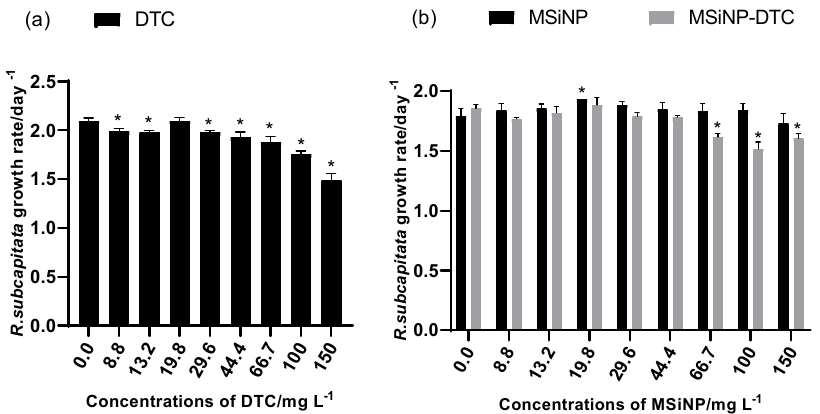
7 100 150 4 6 8 2 8 0 66 . 44 . 29 . 19 . 13 . 8 . 0 . Figure 7. Average R. subcapitata growth rate after 72 h of exposure to DTC ( a ), MSiNPs, and MSiNP-DTC ( b ). Error bars represent the standard deviation, and * corresponds to significant differences between the respective control and the treatments (Dunnett’s test: p < 0.05). DTC: 3-methyl-5-phenyl-pyrazoline-1-( S -benzyldithiocarbazate); MSiNP: mesoporous silica nanoparticles; MSiNP-DTC: DTC-loaded silica nanoparticle. The concentrations of MSiNP-DTC are based on MSiNPs. The amount of DTC in 150 mg L − 1 of MSiNPs is 7.18 mg L − 1 . Currently, there are only a limited amount of data on the effect concentrations ob- served for L. mi nor regarding SiNPs [16,61], and none are related to DTC or analogous compounds. The effects of DTC, MSiNPs, and MSiNP-DTC on L. minor growth assessed